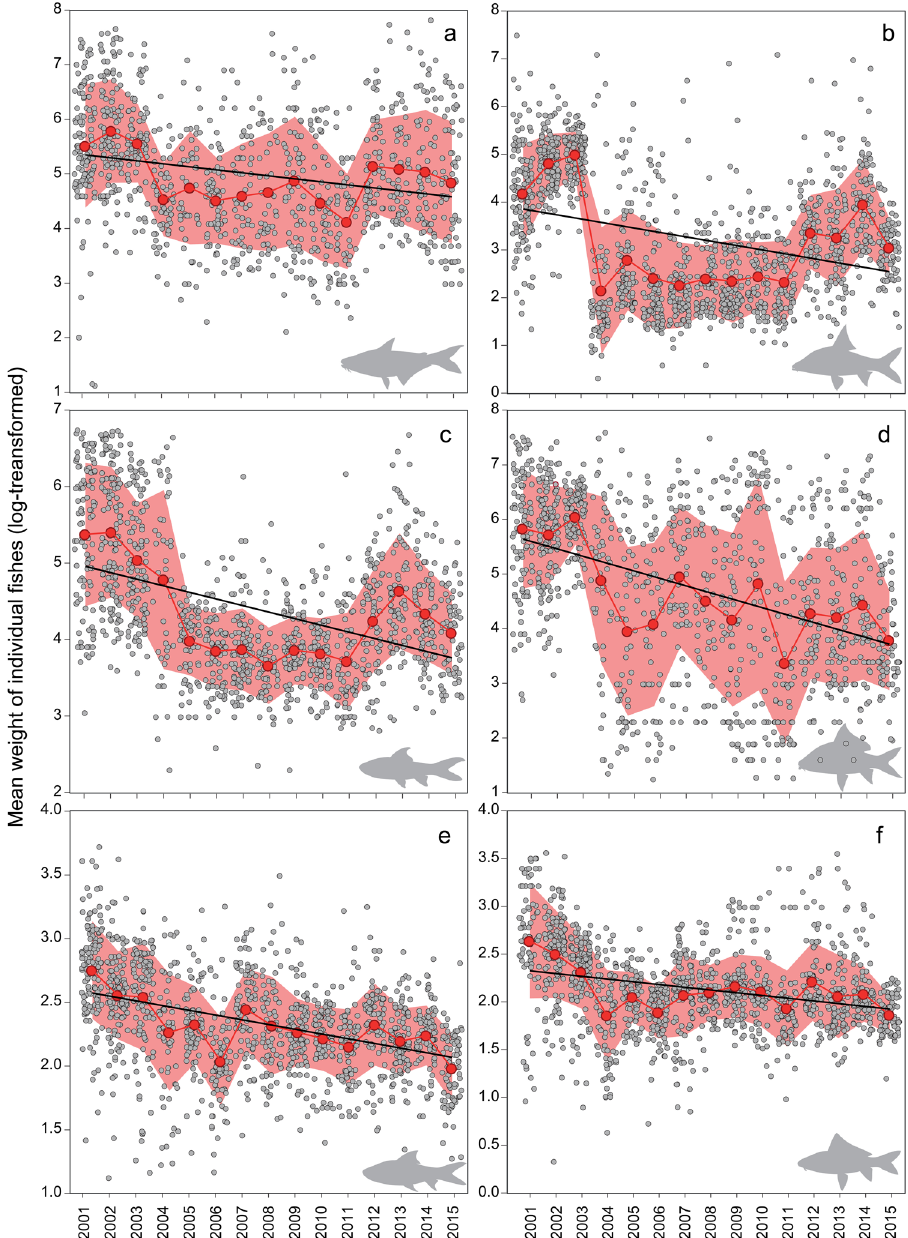
Figure 4. Linear regressions demonstrate temporal change in log-transformed mean individual weight (gram) by season of six common species, composing of large ( a ): Pangasianodon hypophthalmus, ( b ): Cyclocheilichthys enoplos; medium ( c ): Cirrhinus microlepis, ( d ): Osteochilus melanopleurus and small-sized species ( e ): Henicorhynchus lobatus, ( f ): Labiobarbus lineatus that possessed either negative ( a – d ) or positive ( e , f ) catch changes (expressed as standardized regression coefficients, Table S6) from the fishing season of 2000/01 to 2014/15. See Table S7 for parameter estimates. All slopes were significant (p-value < 0.0001). Solid red dots indicate mean body weight and the pink shaded area denotes standard deviation for each survey season across the study period. 2001 represents the fishing season of 2000/01 and the same for other